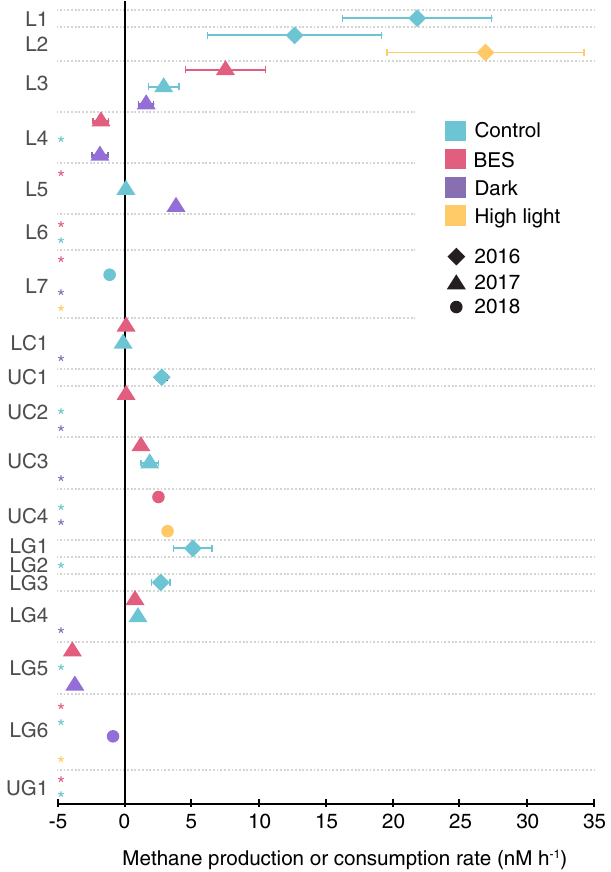
Fig. 1 | Methane (CH 4 ) production or consumption rates across experiments. Different colors represent different treatments or control incubations. Different symbols denote the year of the experiment. Abbreviations at left denote lake (Lukens =L, Lower Cathedral =LC, Upper Cathedral =UC, Lower Gaylor =LG, and Upper Gaylor =UG) and experiment number in each lake (e.g., UC4 is the fourth experiment in Upper Cathedral Lake). Rates were calculated from the slopes of signi fi cant ( P <0.05) correlations between time and triplicate CH 4 concentration measurementsconductedatmultipletimepointsduringexperimentalincubations. Where symbols are not shown, asterisks indicate that no signi fi cant production or consumption occurred. Error bars denote standard errors of slope values for sig- ni fi cant correlations between CH 4 and time; in some cases, these are smaller than the datapoints and are not visible. BES indicates the addition of the methanogen- esis inhibitor 2-bromoethanesulphonate. Source data are provided as a Source Data fi